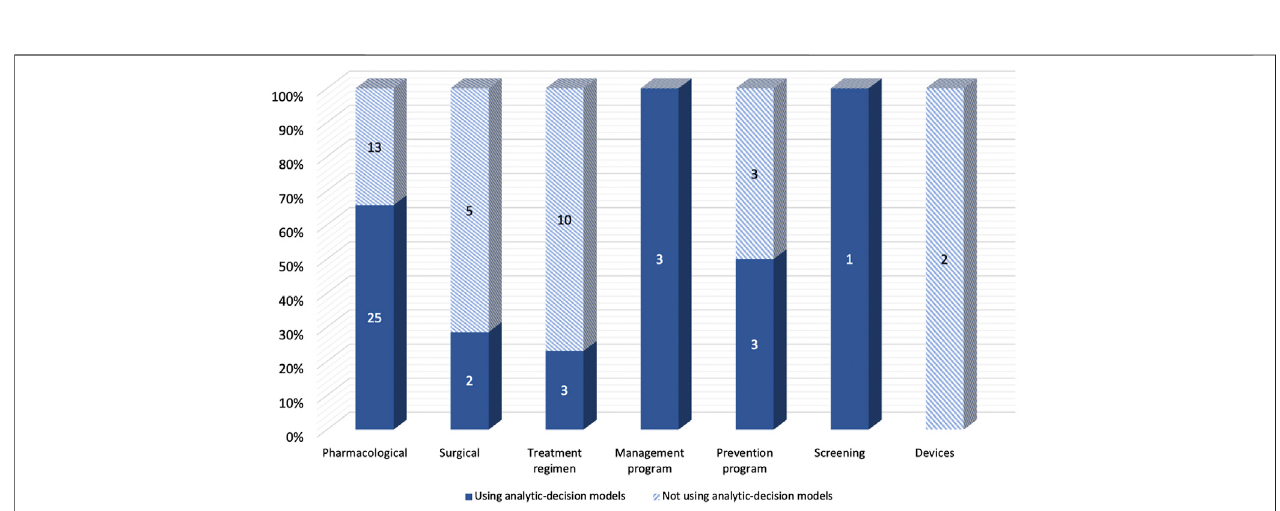
FIGURE 3 | Differences in disease categories between real-world cost-effectiveness analysis with or without decision-analytic model.